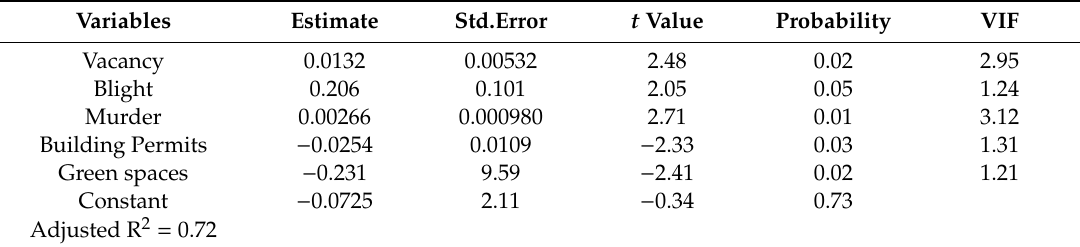
Table 4. Regression of relationship between physical characteristics of the neighborhood and cruelty (Variables removed from the equation due to high VIF include: bus stops; robbery; assault; land bank properties; liquor stores; parks; childcares; and middle and elementary school